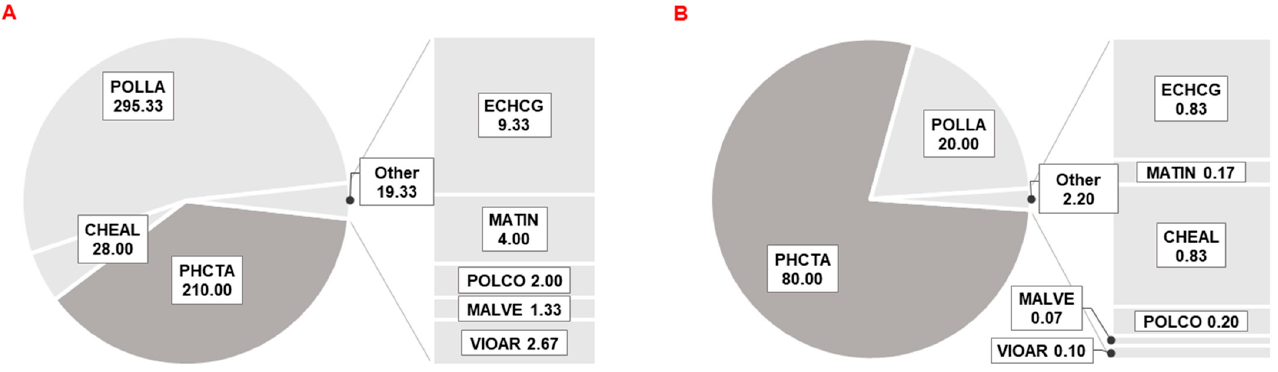
Figure A5. Number of plants per m 2 —Sowing 2 (16th of April) in 2019 ( A ) and leaf coverage in %—Sowing 2 (16th of April) in 2019 ( B ).